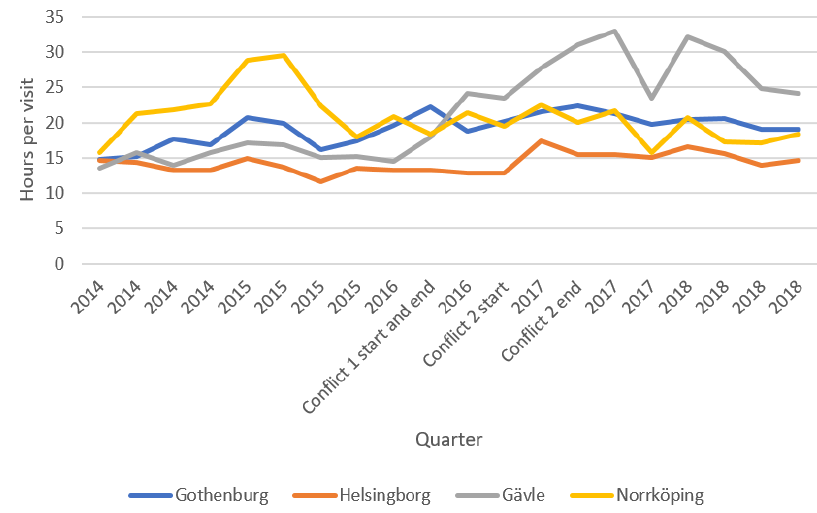
Figure 9. Average hours per visit of ships calling at the four ports.